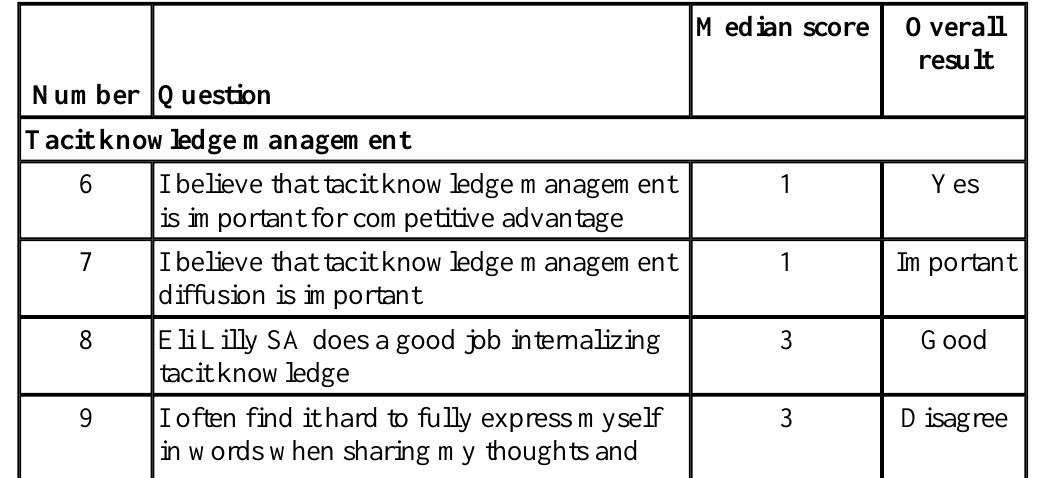
Table 1 Questions and